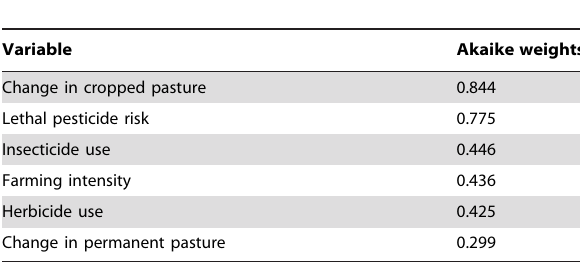
Table 5. Summed Akaike weights for all predictor variables and logit models given in table